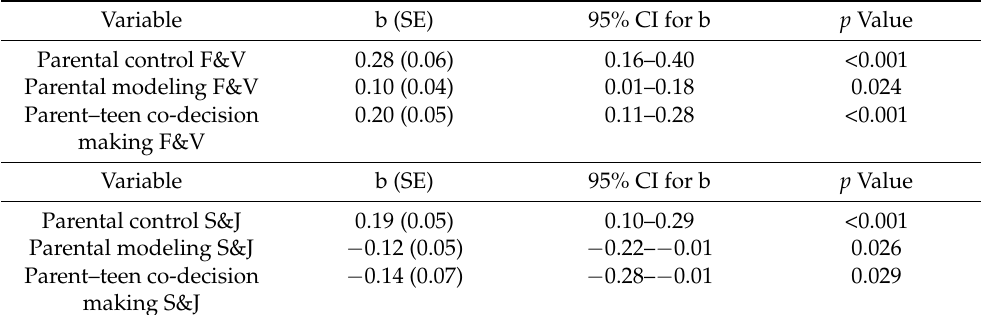
Table 3. Ordinary least-squares regression of adolescents’ fruit and vegetable or sugar-sweetened beverage and junk food consumption.